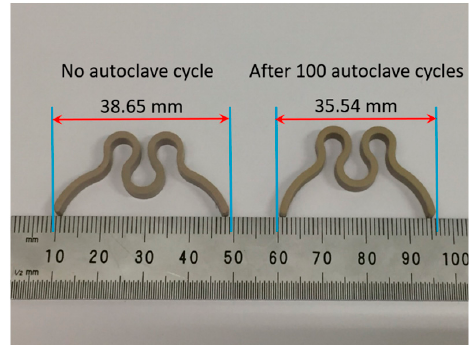
Figure 3. Clip component lateral dimension before and after 100 sterilization cycles.